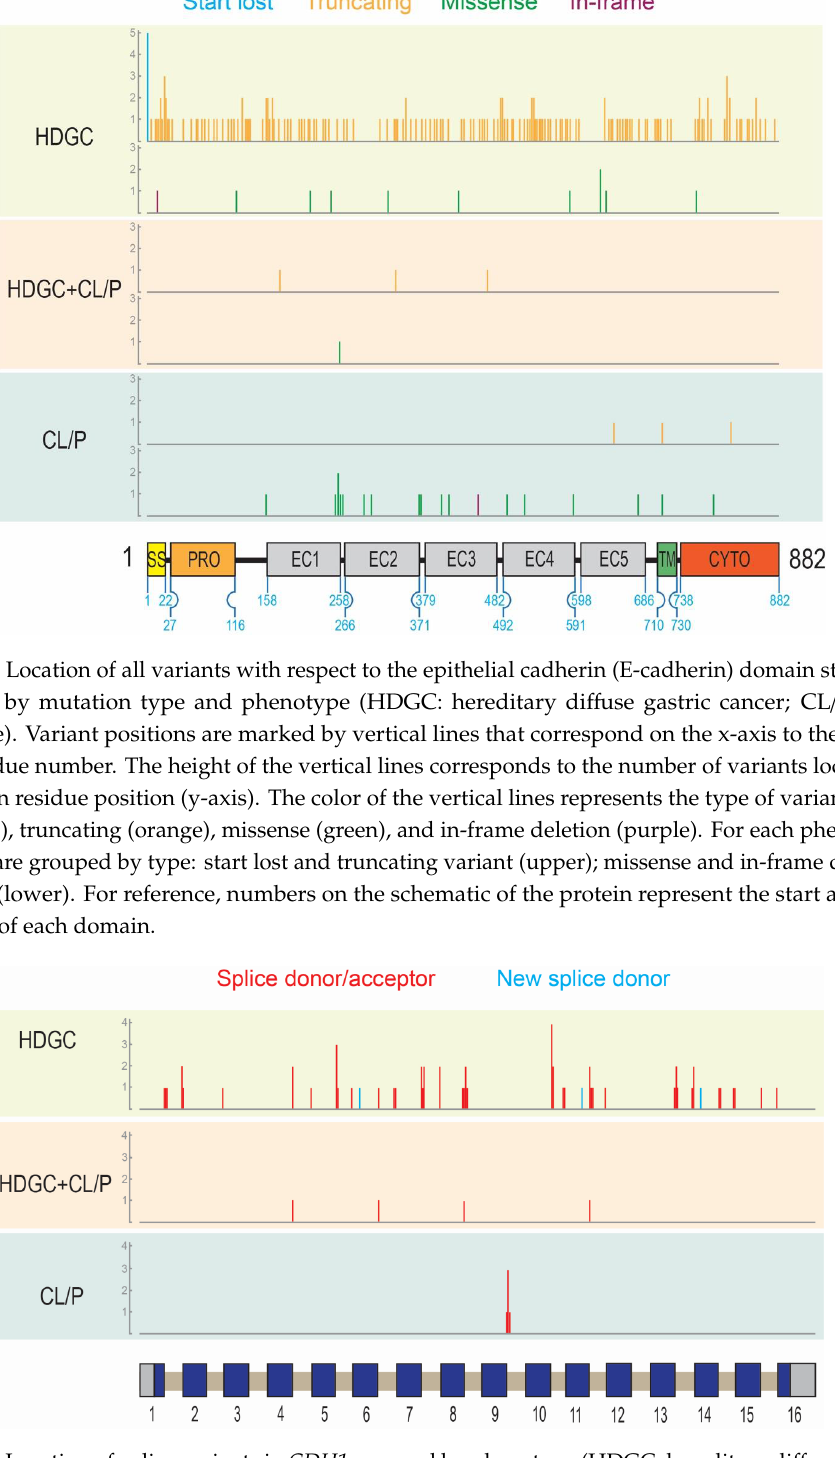
Figure 2. Location of splice variants in CDH1 grouped by phenotype (HDGC: hereditary diffuse gastric cancer; CL/P: cleft lip/palate). Vertical lines correspond to the approximate location of the variants with respect to the gene structure (schematic; x-axis). Exons are shown as boxes: coding region (blue); untranslated regions (grey). Introns (tan) and exons are not drawn to scale. The height of the vertical lines corresponds to the number of variants located at that given position (y-axis). The color of the vertical lines represents the type of variant: splice donor/acceptor variants (red), new splice donor (light blue).